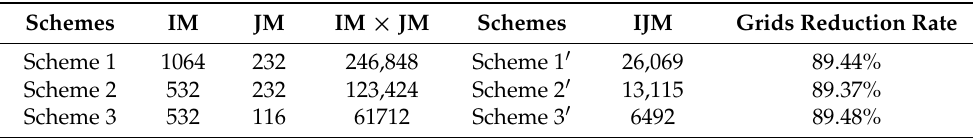
Table 3. Six schemes of grids used for computational efficiency